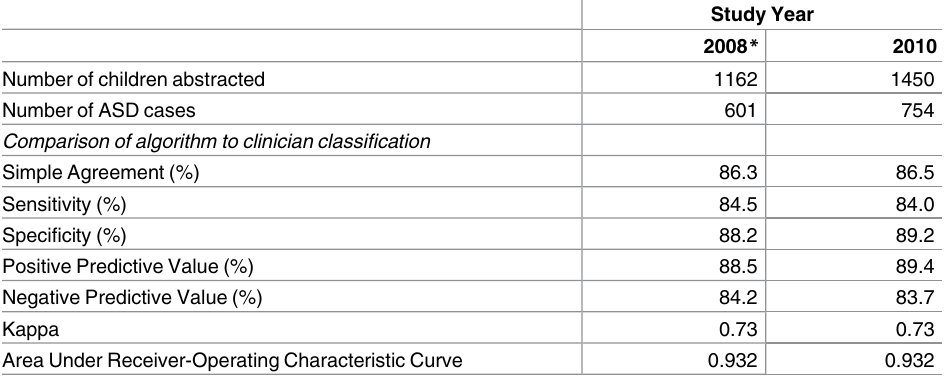
Table 1. Comparison between clinician-assigned surveillance autism spectrum disorder (ASD) case status and predictions from random forest algorithm.